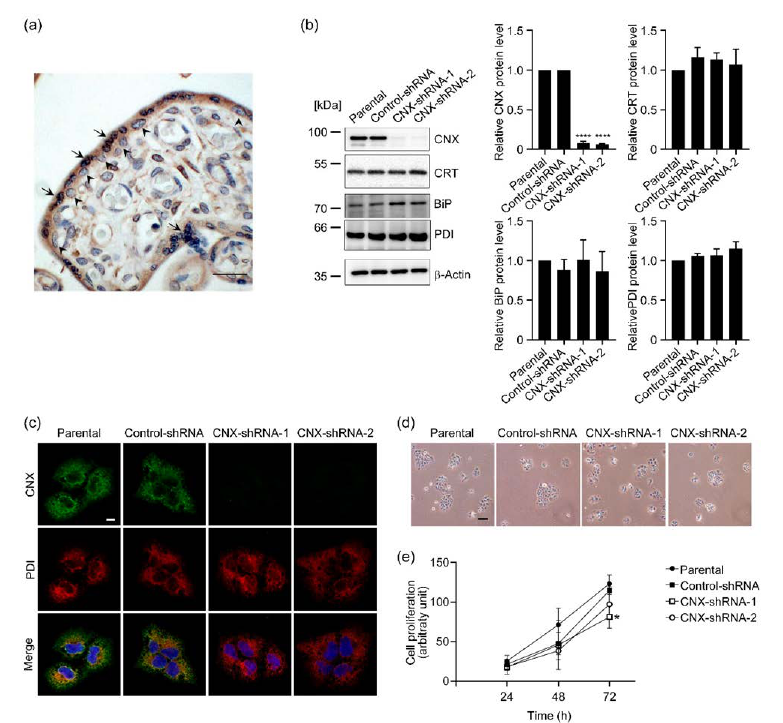
Figure 1. Stable knockdown of CNX expression in BeWo cells. ( a ) Representative section of third- trimester normal placenta was subjected to immunohistochemistry with anti-CNX antibody. STB cytoplasm and CTB cytoplasm were positive for CNX. Arrows show CNX-positive STBs and arrow- heads show CNX-positive CTBs. Scale bar, 20 µ m. ( b ) We investigated the levels of the ER-resident chaperones CNX, CRT, BiP, and PDI by means of immunoblot analysis with specific antibodies in parental cells, mock-transfected cells (Control-shRNA), and CNX-knockdown cells (CNX-shRNA-1 and CNX-shRNA-2). β -Actin served as the loading control. The graphs show quantification of the levels of each chaperone. Data are shown as means ± SD of three independent experiments. **** p < 0.0001. ( c ) Intracellular localization of CNX and PDI was studied in parental cells, Control- shRNA cells, and CNX-knockdown cells by using immunofluorescence microscopy with specific antibodies. PDI staining was used to show the ER. Scale bar: 20 µ m. ( d ) Cell morphology was examined by using phase-contrast microscopy. Scale bar: 100 µ m. ( e ) Cell proliferation was estimated photometrically in parental cells, Control-shRNA cells, and CNX-knockdown cells by means of crystal violet staining as described in Materials and Methods. Data are shown as means ± SD of three independent experiments. * p < 0.05 vs. Control-shRNA cells (72